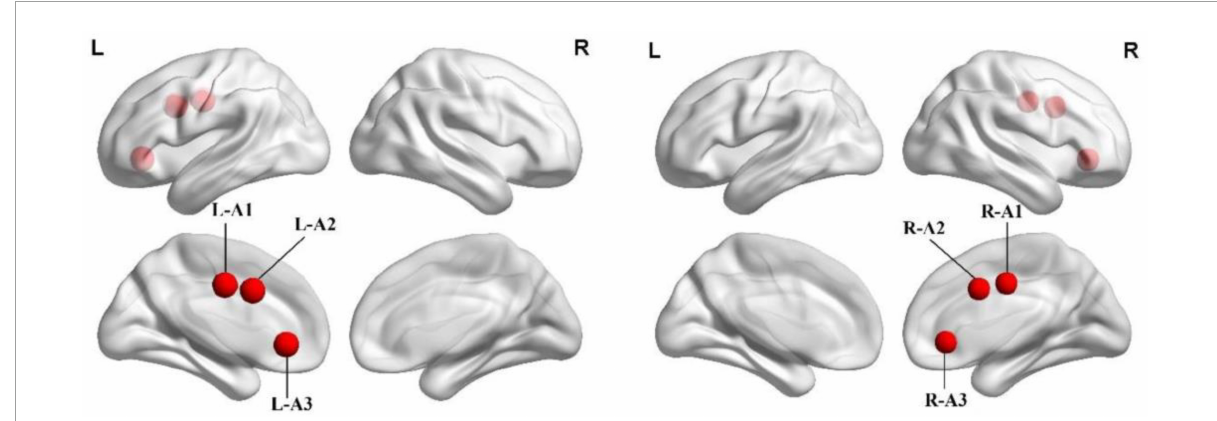
FIGURE1 Spatial location of the anterior cingulate cortex subregions. A1, caudal anterior cingulate cortex; A2, dorsal anterior cingulate cortex; A3, subgenual anterior cingulate cortex; L, left; R, right.